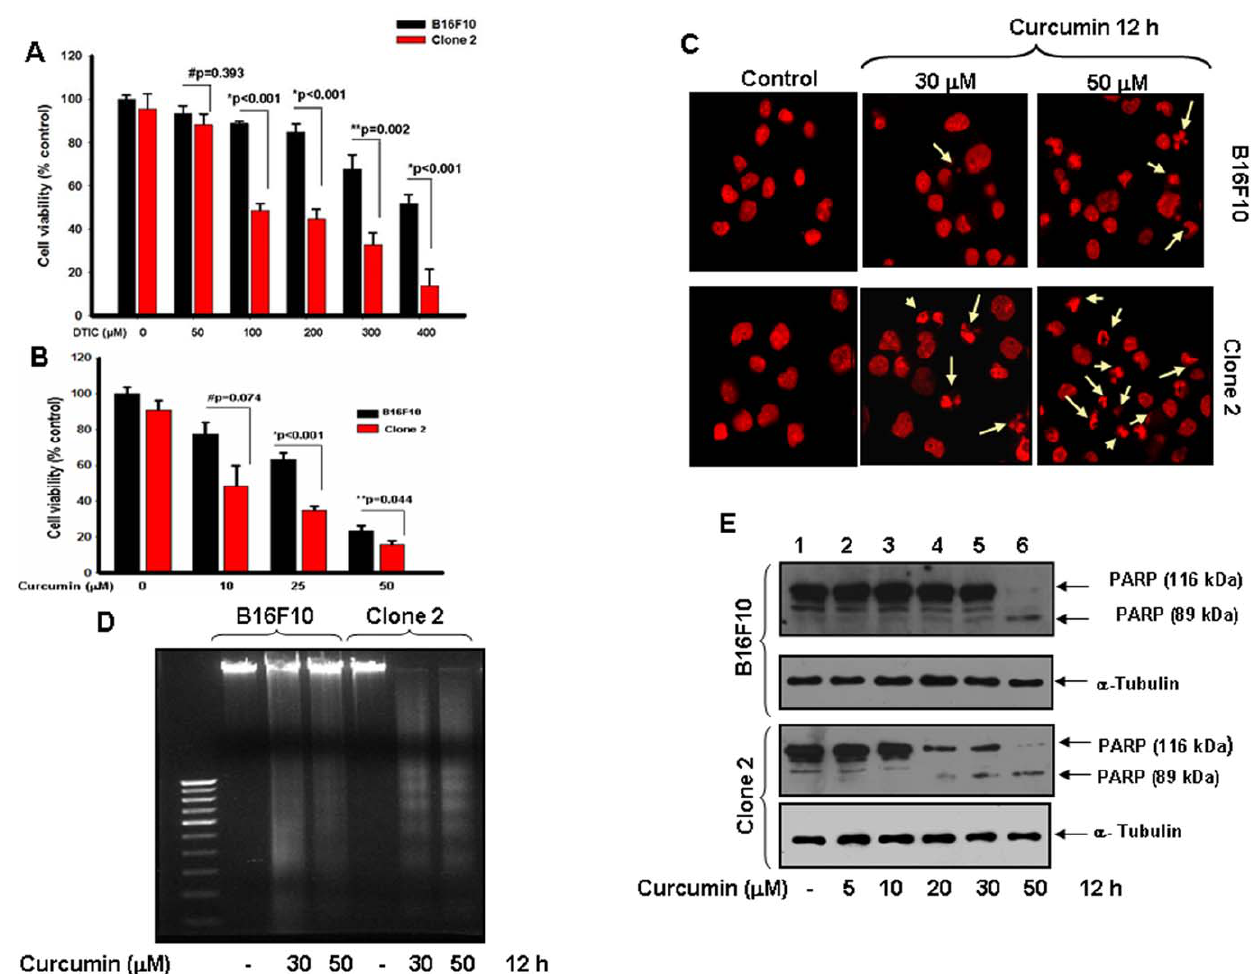
Figure 5. Sema 3A overexpressed clone exhibits increased drug sensitivity in B16F10 cells. ( A ) Control or clone 2 cells were treated with melanoma specific drug, Dacarbazine (DTIC) (0–400 m M) for 24 h and cells survival was analyzed by MTT assay. # p=0.393, *p , 0.001, **p=0.002 vs. respective treatment group within B16F10 and clone 2 cells. ( B ) Similarly, both cells were treated with curcumin (0–50 m M) for 12 h and cell viability was checked by MTT assay. The data are represented in the form of bar graph and the mean value of triplicate experiments is indicated. # p=0.074, *p , 0.001, **p=0.044 vs. respective treatment group within B16F10 and clone 2 cells. ( C ) Both cells were treated with indicated concentrations of curcumin, fixed and stained with PI (red) and photographed under fluorescence microscope at 60 6 magnifications. The apoptotic nuclei are indicated by arrows. ( D ) Cells were treated with two doses of curcumin for 12 h. Fragmentation of genomic DNA was extracted and resolved on 2% agarose gel. Apoptotic DNA fragmentation was visualized by ethidium bromide staining. ( E ) Curcumin induced apoptosis in control and clone 2 cells were also analyzed by Western blot using anti-PARP antibody. Cells were treated with 0–50 m M curcumin for 12 h and then analyzed by Western blot. a -Tubulin was used as loading control. The experiments showed here are representative of triplicate independent experiments with similar